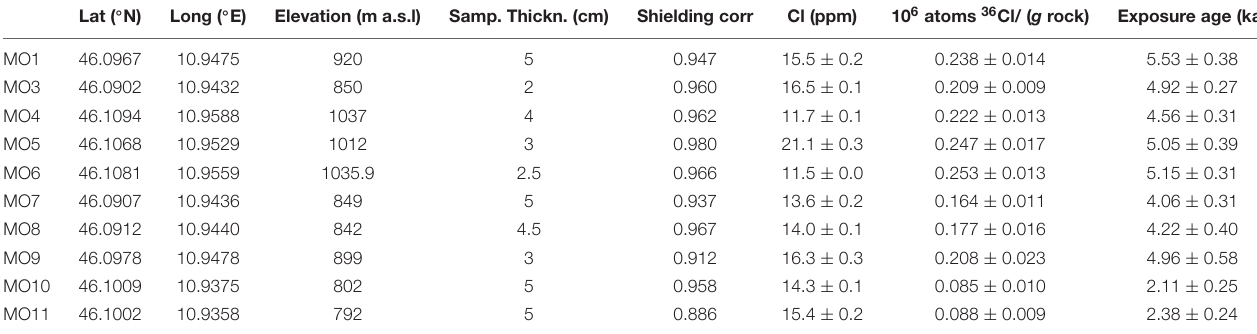
TABLE 2 | Sample data. Spatial location, orientation, thickness, chlorine concentration, and calculated ages.